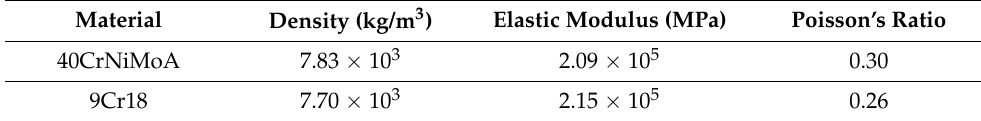
Figure 8. Distribution of the contact parameter results of the spline shaft model: ( a ) relative sliding distance; ( b ) contact stress. Table 7. The material properties of the M298K and 9Cr18